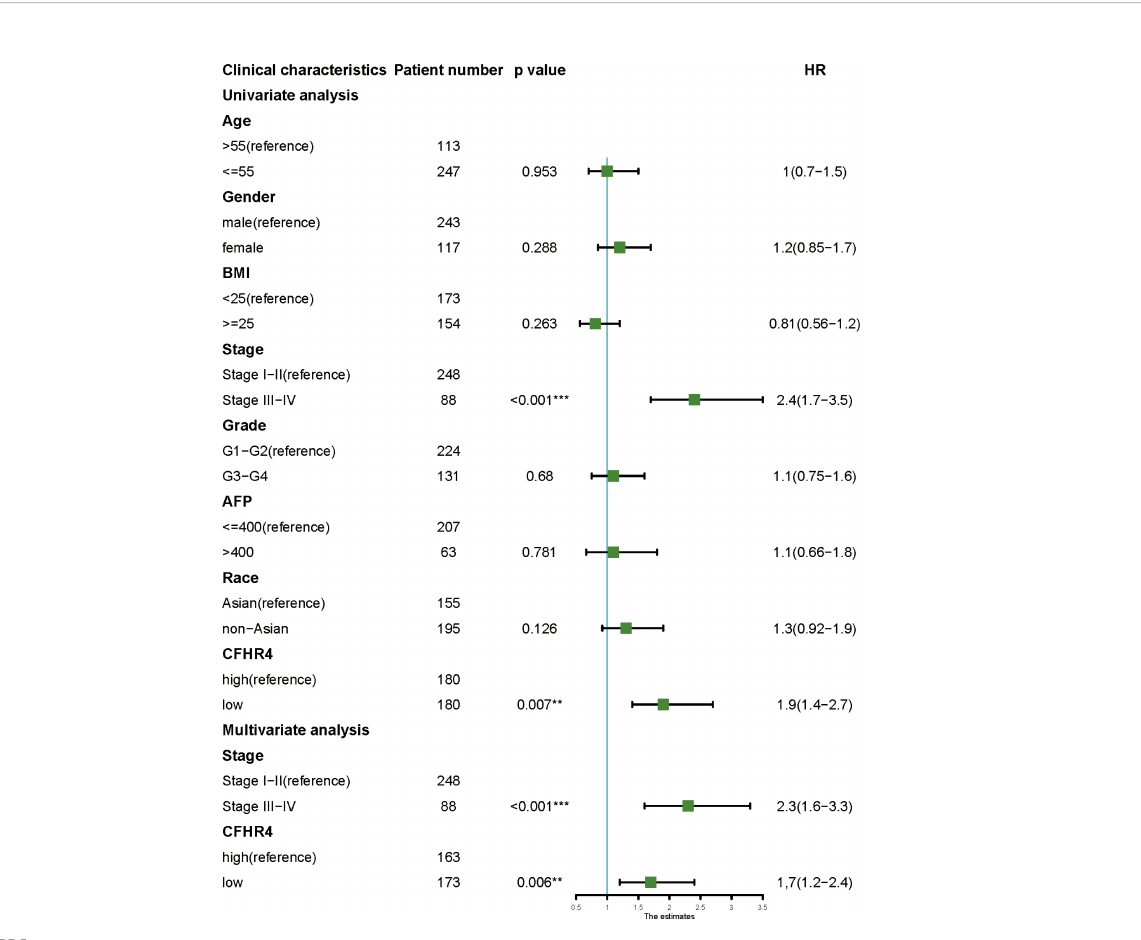
FIGURE 5 Univariate and multivariate analyses of clinicopathological factors for OS in HCC. P < 0.01 **, P < 0.001